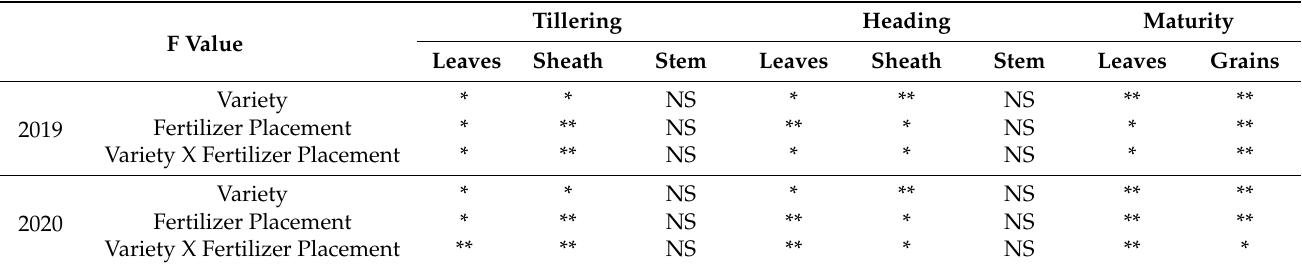
Table 6. The effects of the interactions between variety and fertilizer placement on AP content ( µ g kg − 1